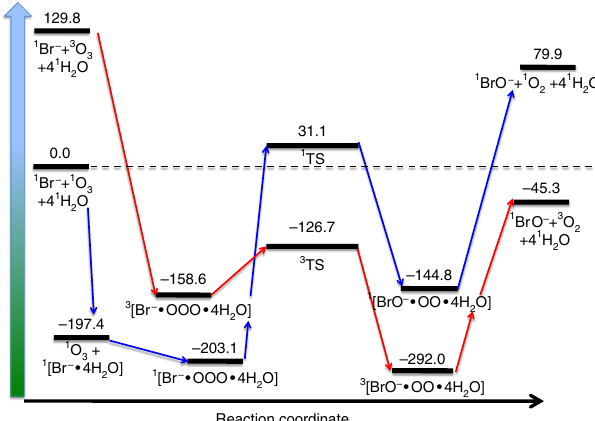
Fig. 2 Energetic pro fi le for the bromide-ozone reaction with water molecules. The fi gure reports the energetic pro fi le for the reaction of bromide with ozone in a cluster consisting of four water along the singlet ( blue ) and triplet ( red ) surface. Electronic structure calculations were performed at CCSD(T)/6 – 311++G(df,p)//MP2/6 – 311++G(df,p) level. All energies, which include the Zero Point Energy (ZPE) correction, are relative to the singlet reactants and are reported in kJ mol − 1 . The spin crossing between the two potential energy surfaces is highlighted by the intersection of the red and blue arrows between the pre-reaction complexes and the transition